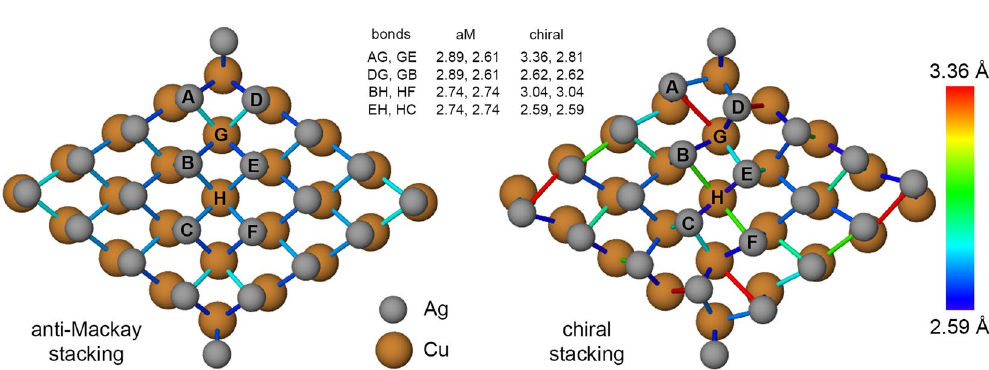
Figure 10. Ag-Cu bonds in anti-Mackay and chiral stacking at the size 521. In the direction which is roughly parallel to the direction where new Ag-Ag bonds are formed on the surface (DB, EC), the Ag-Cu bonds contract and in the perpendicular direction, the Ag-Cu bonds expand. The bond lengths (in Å ) of certain Ag-Cu bonds are listed for anti-Mackay (aM) stacking and chiral stacking assuming the bonds are retained in chiral stacking. Ag atoms are drawn with smaller radius to clearly show the subsurface Cu